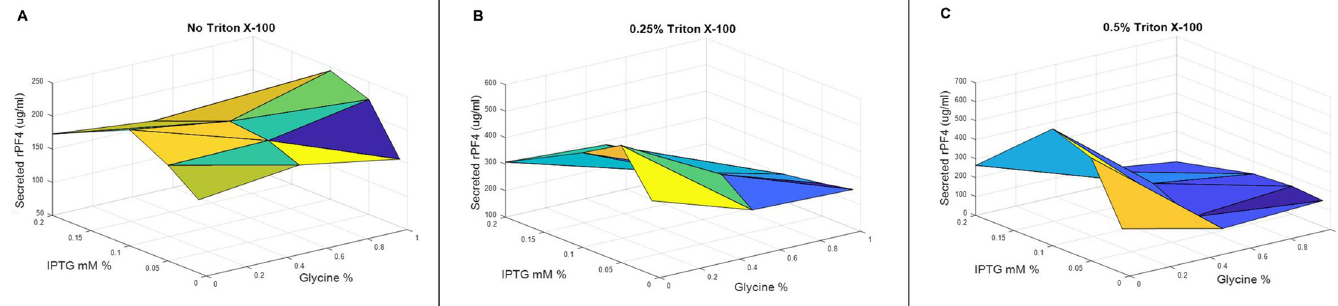
Fig 10. A three-dimensional representation of the synergistic effects on the rPF4 secretion of supplementation with various concentrations of glycine, Triton X- 100, and IPTG. (A) In the absence of Triton X-100, the best secretion level is achieved by moving toward lower IPTG concentrations near 0.1 mM. In addition, tweaking glycine concentration does not seem to result in any significant change in the protein secretion level. (B) When the cocktail medium is supplemented with 0.25% Triton X-100, the optimum secretion point is achieved by moving toward zero glycine concentration and 0.1 mM IPTG. (C) At 0.5% Triton X-100 concentration, the optimum secretion level is brought about at zero glycine concentration and 0.05–0.1 mM IPTG.